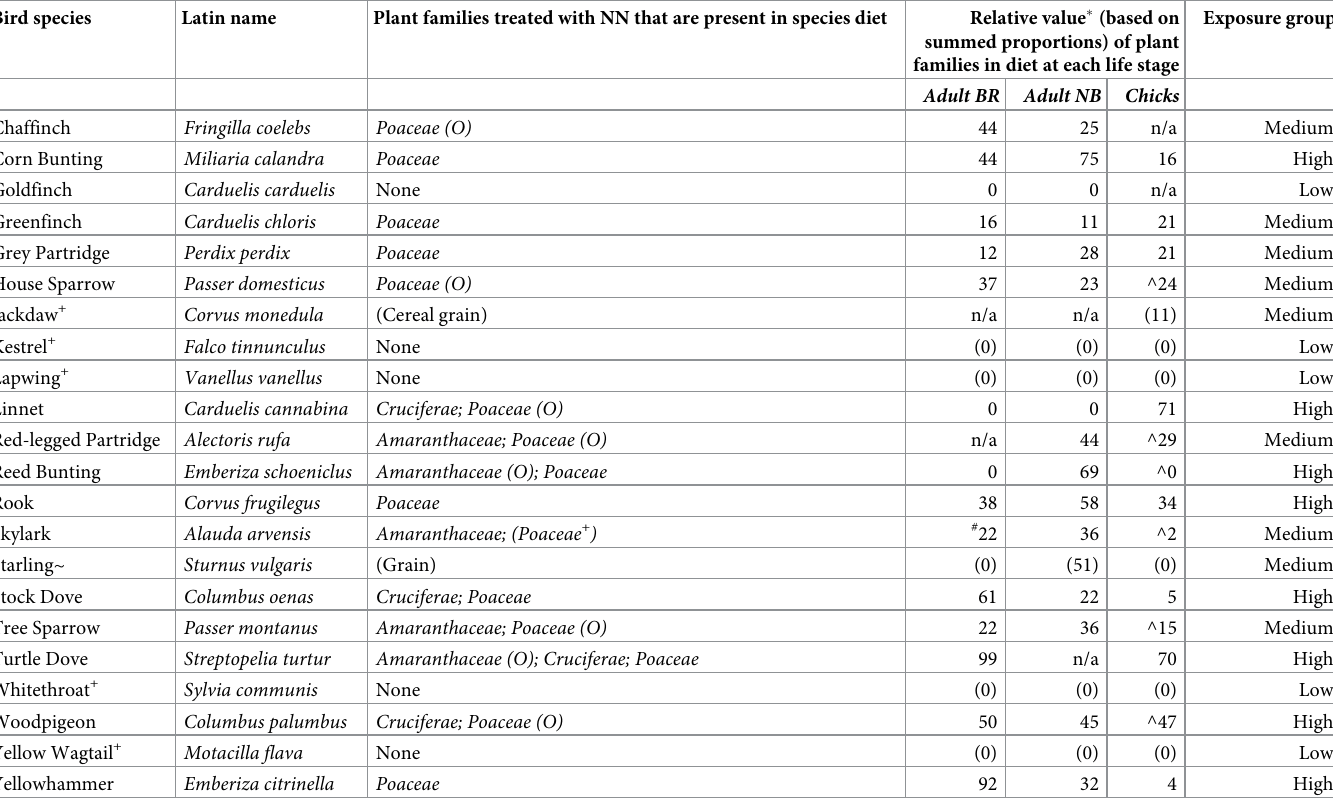
Table 3. Relative quantity of high-level residue food items in species diet and dietary exposure groups assigned to each species.